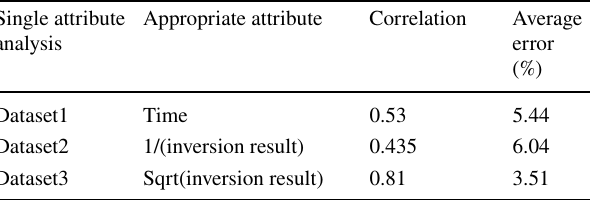
Table 5 The results of applying single-attribute regression on the data